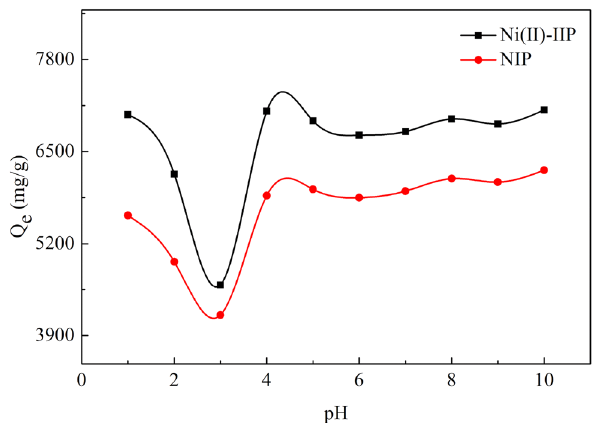
Figure 10: E ff ect of pH on adsorption